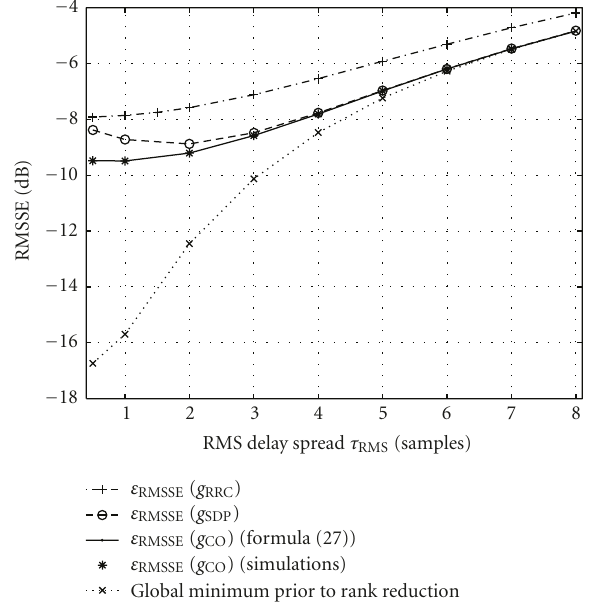
Figure 4: Model errors by windows g CO [ k ] and g SDP [ k ] optimized through CO and SDP, respectively, and by window g RRC [ k ] with RRC-shaped magnitude spectrum versus τ RMS at ν RMS = 10 − 2